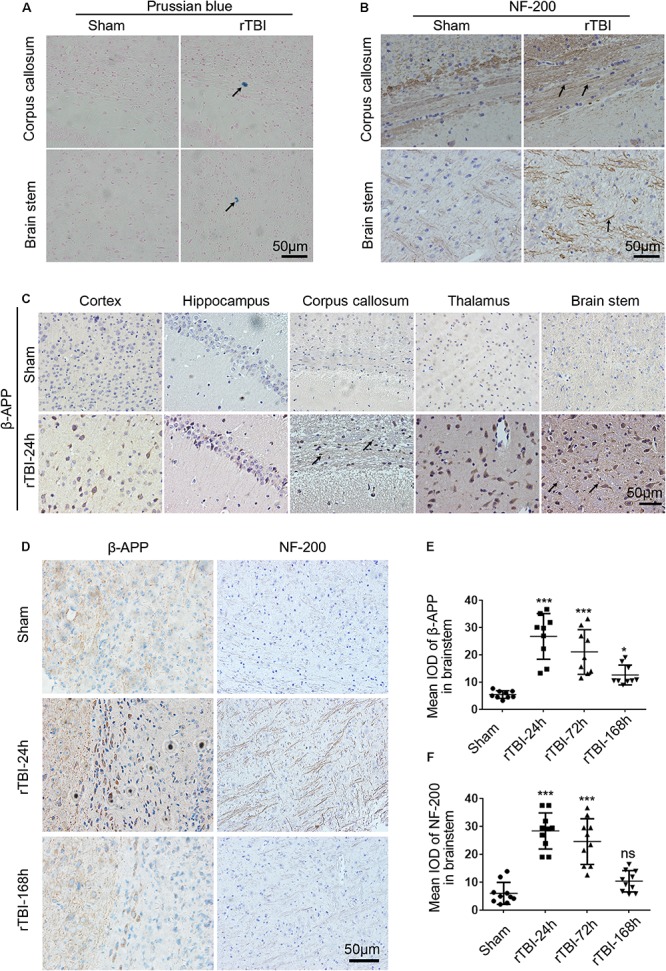
Histopathological changes induced by repetitive traumatic brain injury (rTBI). rTBI induced histopathological changes in Prussian blue, neurofilament heavy-chain (NF-200), and amyloid precursor protein (β-APP) in multiple brain regions. (A) Representative microbleed as identified by Prussian blue staining at 72 h post last injury; microbleed was indicated by a black arrow. (B) Immunochemical staining of mouse brain sections showing NF-200 staining in the corpus callosum and brain stem at 24 h after injury compared to sham-treated mice. Axons positively stained for NF-200 were shown with black arrows. (C) Immunochemical staining of mouse brain sections shows β-APP accumulation in neuronal cell bodies in the subcortical areas, hippocampus, corpus callosum, thalamus, and brain stem at 24 h after injury compared to sham-treated mice. β-APP immunoreactive staining of axonal profiles was observed as being granular in the corpus callosum and brain stem, as indicated by a black arrow. (D) Histopathology of β-APP and NF-200 staining in the brain stem white matter in mice following rTBI (24–168 h) compared to sham-treated mice. (E) The mean integrated optical density (IOD) of β-APP-stained neuronal cell bodies per micrograph as a function of time following rTBI in the brain stem. (F) The mean IOD of NF-200-stained axons per micrograph as a function of time following rTBI in the brain stem. ∗∗∗p < 0.001 and ∗p < 0.05; ns, no significance.